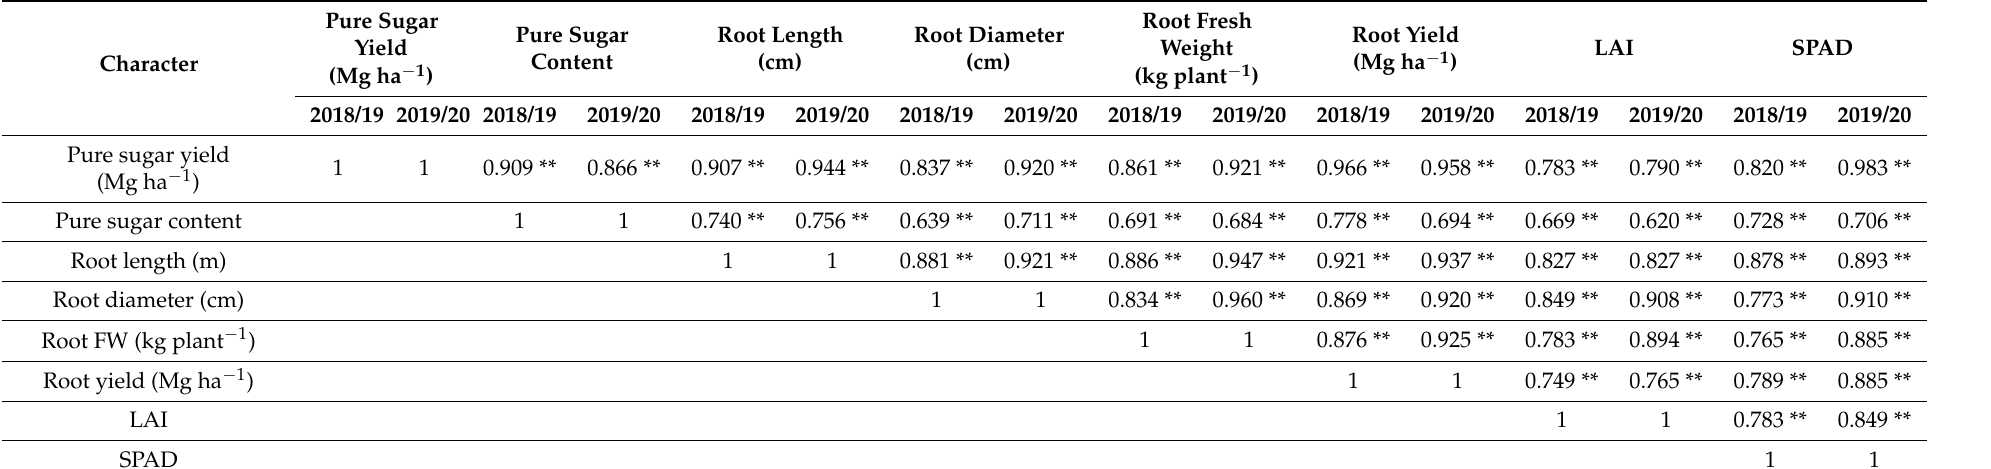
Table 7. A matrix of Pearson’s correlation coefficient between pure sugar yield (Mg ha − 1 ) and other important traits estimated of sugar beet during two growing seasons under soil salinity (ECe = 8.96 dS m − 1 )